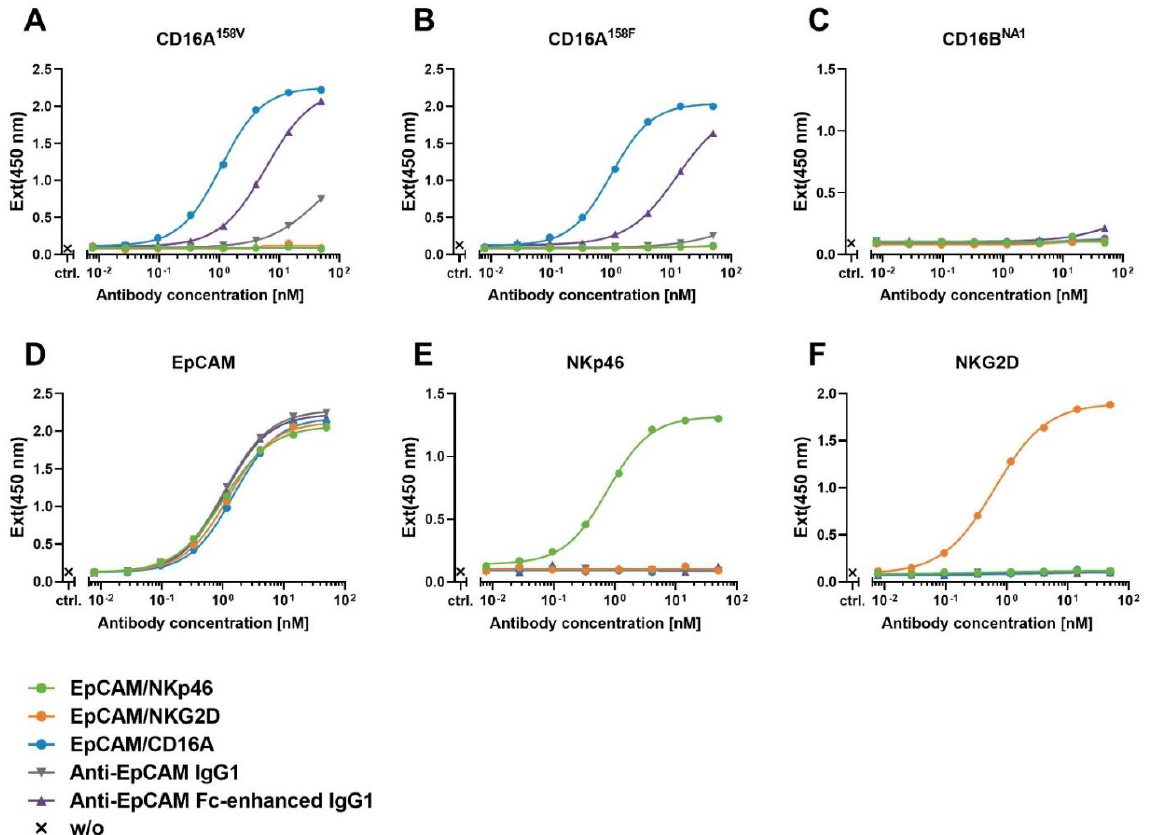
Figure 2. Assessment of the binding and specificity of bispecific ICE ® constructs to recombinant human CD16A, CD16B, EpCAM, NKp46, or NKG2D antigens measured by ELISA.ELISA was used to analyze the binding of ICE ® constructs or control IgG antibodies to plates coated with human CD16A 158V ( A ), CD16A 158F ( B ), CD16B NA1 ( C ), EpCAM ( D ), NKp46 ( E ), or NKG2D ( F ). Bound antibodies were detected with the HRP-conjugated anti-lambda light chain-secondary antibody and measured in TMB substrate reactions at 450 nm. ELISA, enzyme-linked immunosorbent assay; Ext, excitation; HRP, horseradish peroxidase; TMB, 3,3 ′ ,5,5 ′ -tetramethylbenzidine. Table 2. Binding affinity and specificity of ICE ® constructs to recombinant human EpCAM, CD16A, CD16B, NKG2D, and NKp46 antigens measured by ELISA.